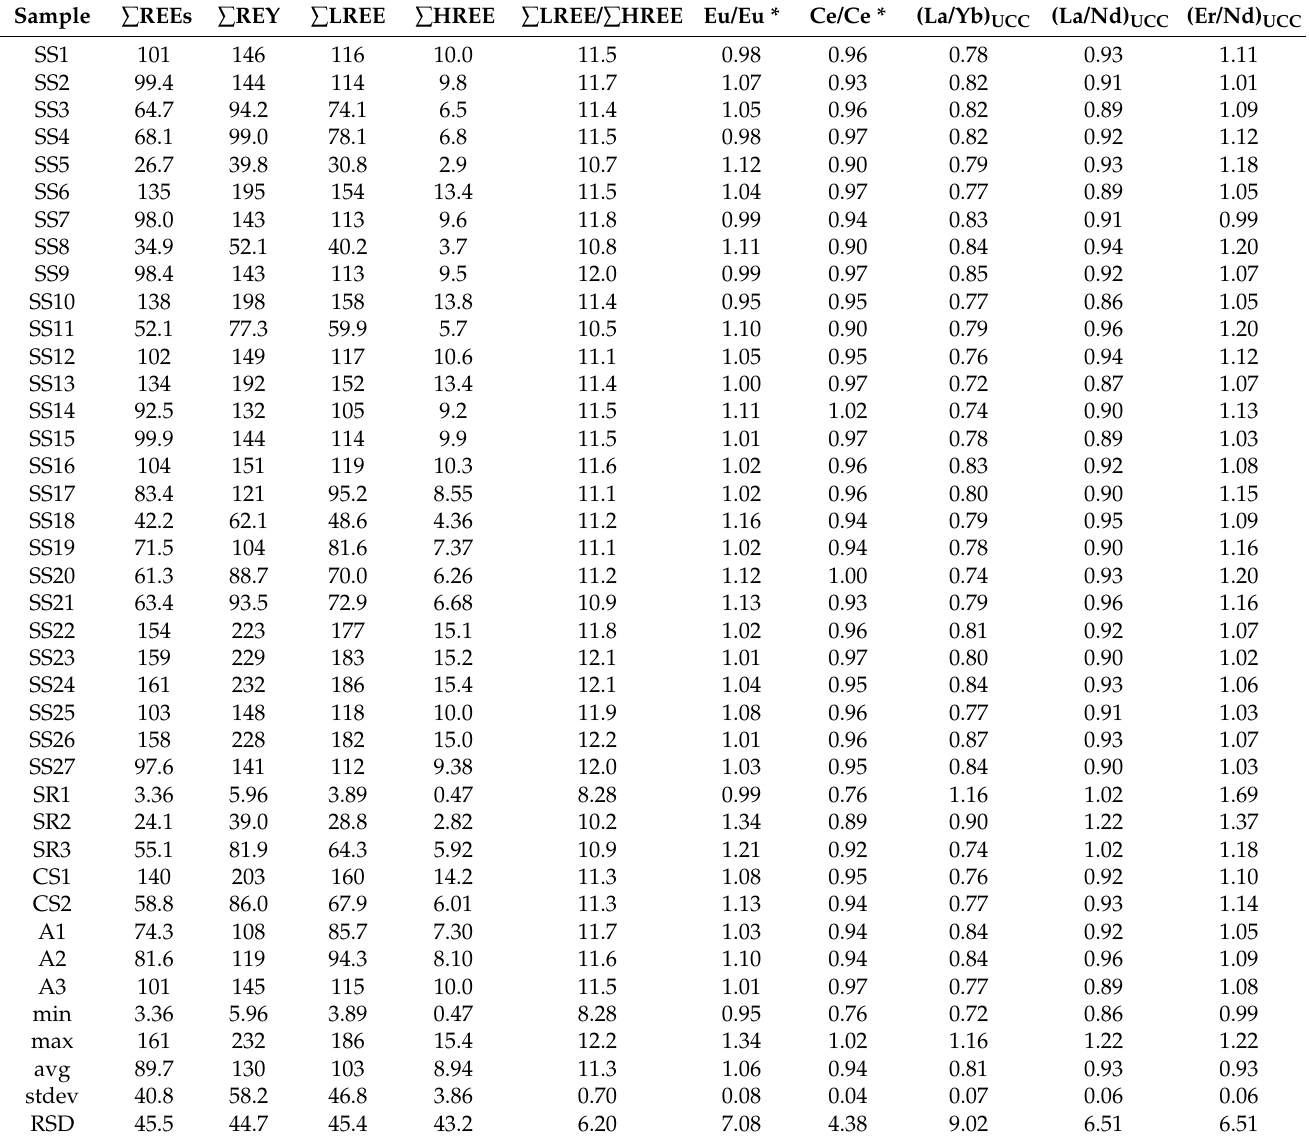
Table 6. Calculated anomalies and fractionation indices for REEs in studied